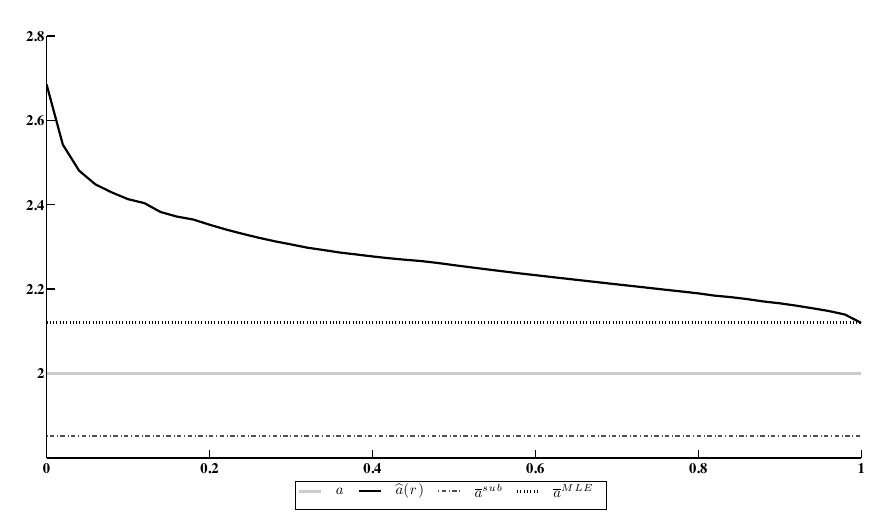
Figure 3. Estimation of the coefficient a under conformity constraint based on the likelihood function. Figure 4 contains: